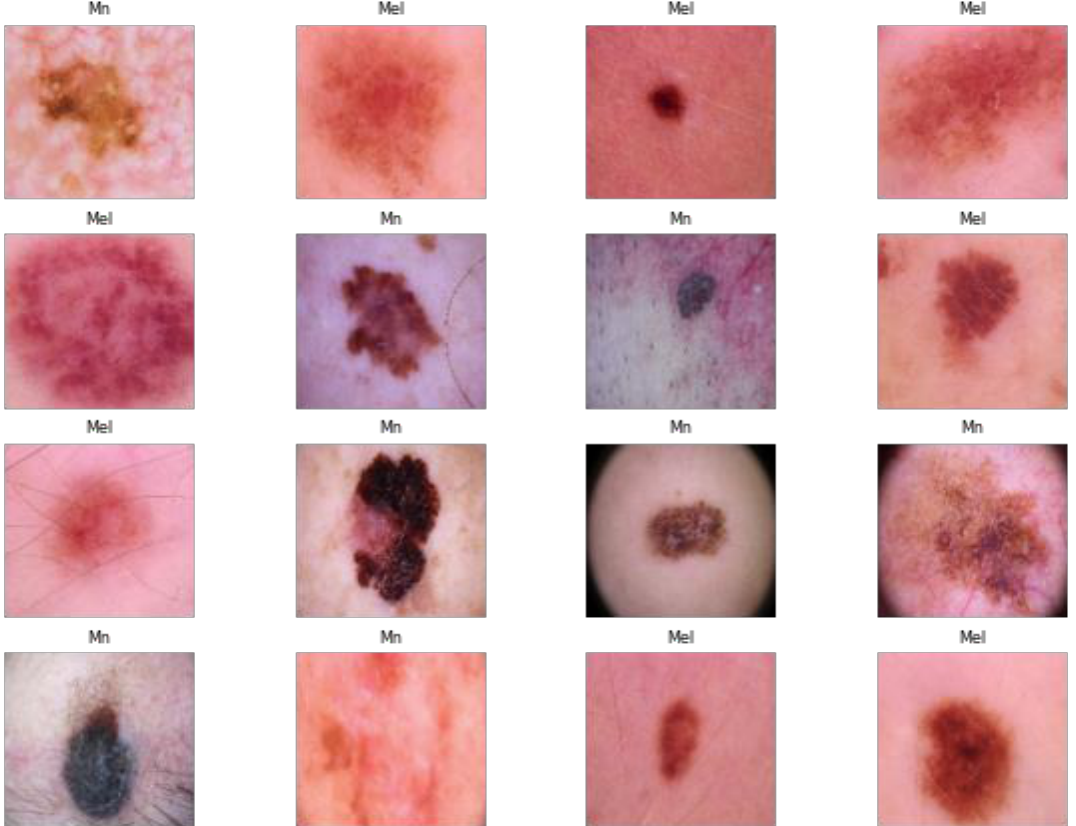
Figure 2. Original image samples of skin cancer extracted from three datasets.